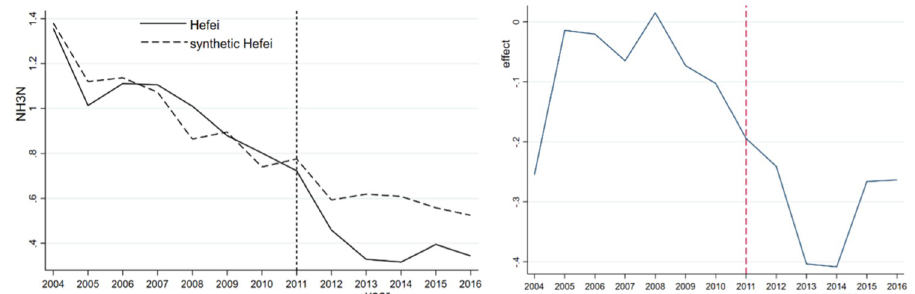
Fig 2. NH 3 N and its effect for Hefei and synthetic